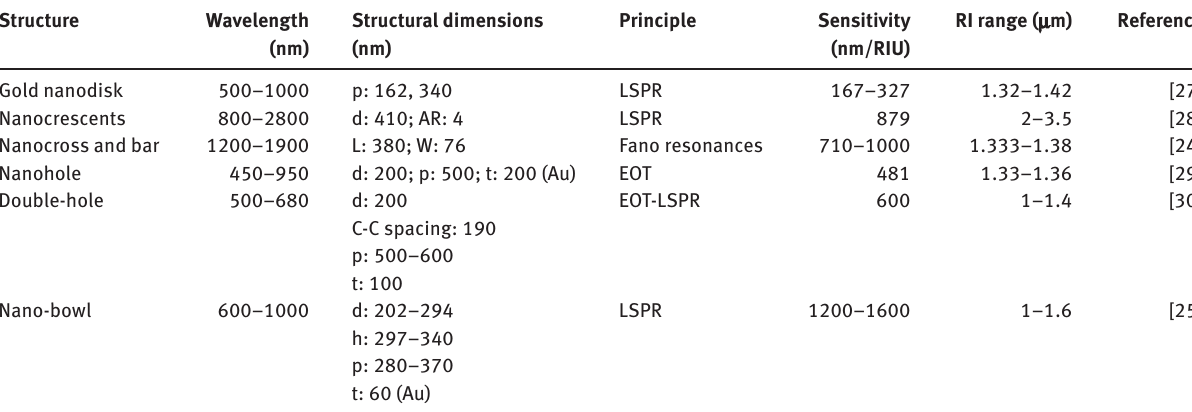
Table 1: Comparison of sensitivity of different nano-array plasmonic sensors [26].